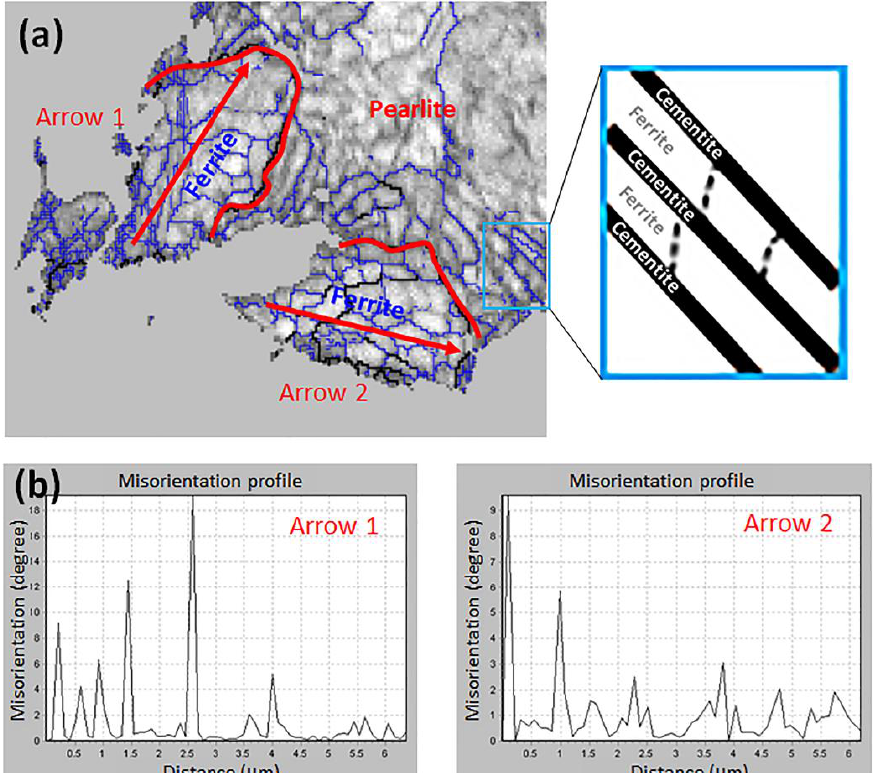
Figure 3. ( a ) An enlargement of the area in the red box of Figure 2, the black lines show dislocation boundaries with misorientation angles of θ > 15° and the blue lines show low angle boundaries with misorientation angles of 2° < θ < 15° within the two ferrite grains. ( b ) Shows the misorientation profiles between neighboring points along the two arrows in the ferrite grains in ( a ). Please note that cementite lamellae are seen as dark grey lines because they cannot be indexed because they are very thin, only several tens of nanometers. Part of the structure with two ferrite and three cementite lamellae in the light blue box is sketched and enlarged with dashed lines in ferrite lamellae, representing dislocation boundaries.